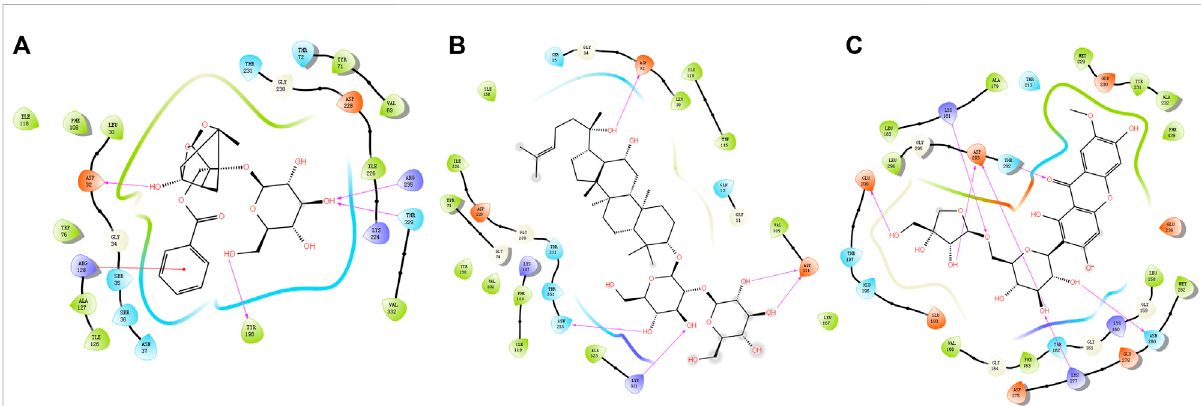
FIGURE 5 Molecular docking models depicting interactions between YZD components and their putative molecular targets/receptors. (A) APP (Beta amyloidA4proteinBeta,PDBcode:6UWP) interactingwithPaeoni fl orin; (B) BACE(Beta-secretase1,PDBcode:5CLM)interactingwithGinsenoside Rg3; (C) GSK3B (Glycogen synthase kinase-3 beta, PDB code: 1O6L) with Polygalaxanthone. Structures drawn entirely in black represent YZD components, the colored dots are amino acid residues from the interacting protein. Pink arrows represent hydrogen bonds while red lines indicate a P- π conjugate.